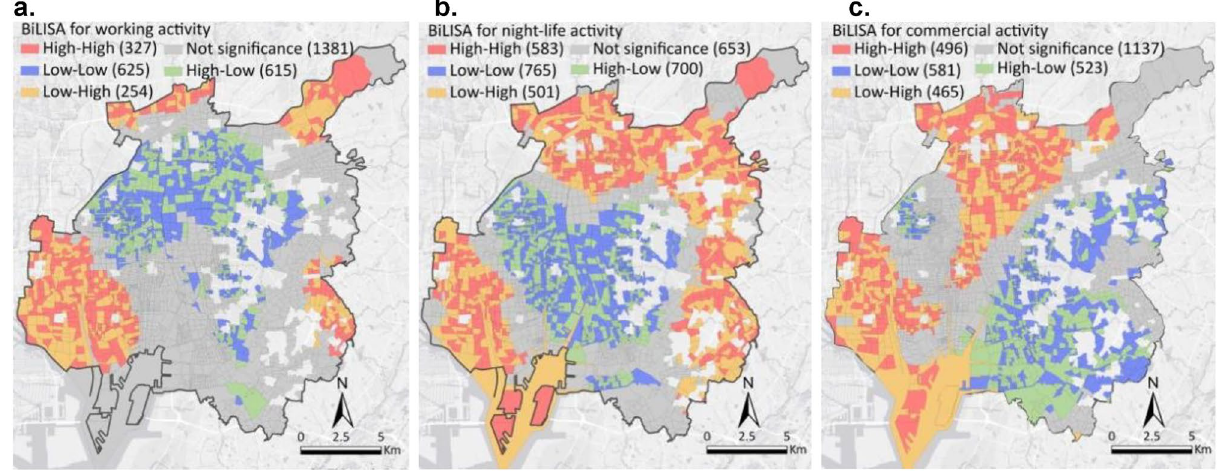
Figure 3. BiLISA between activation rates and activation mean values in Nagoya. ( a – c ) The BiLISA results for working activity ( a ), night-life activity ( b ), and commercial activity ( c ); created using ArcGIS Pro Version 2.9 from ESRI (http:// www. arcgis.